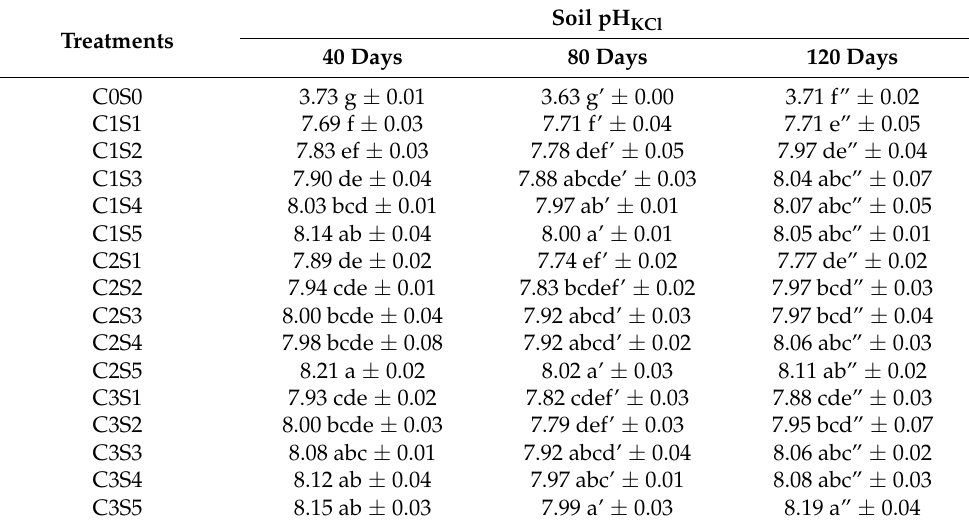
Table 4. Mean soil pH KCl in relation to combined use of Calciprill and sodium silicate at forty, eighty, and one hundred and twenty days